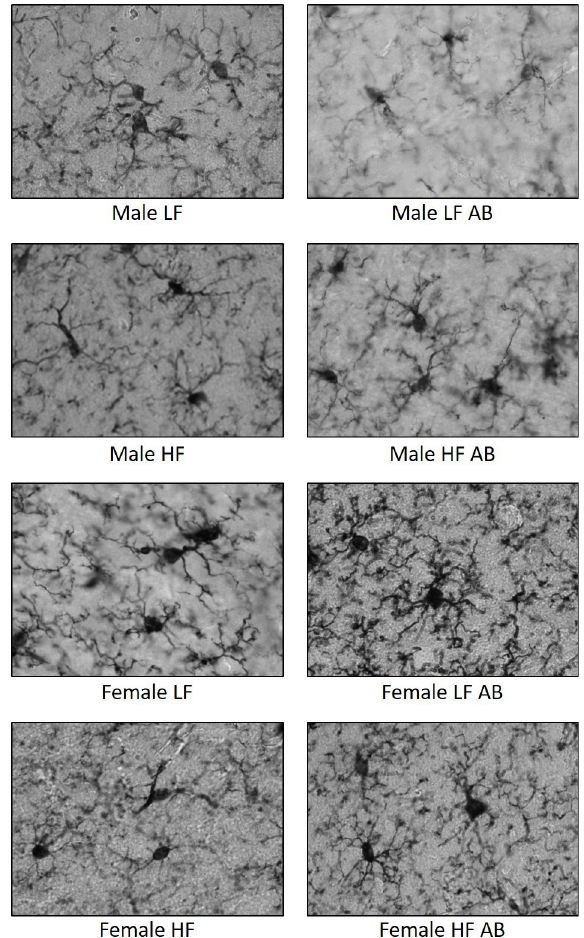
Fig 7. Representative micrographs of microglia. 100X images were collected for microglia labeled with the Iba-1 antibody.